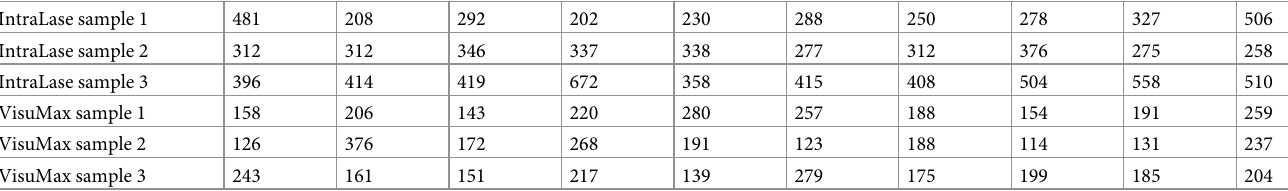
Table 2. Root mean square values (nanometers) of each 20x20 area